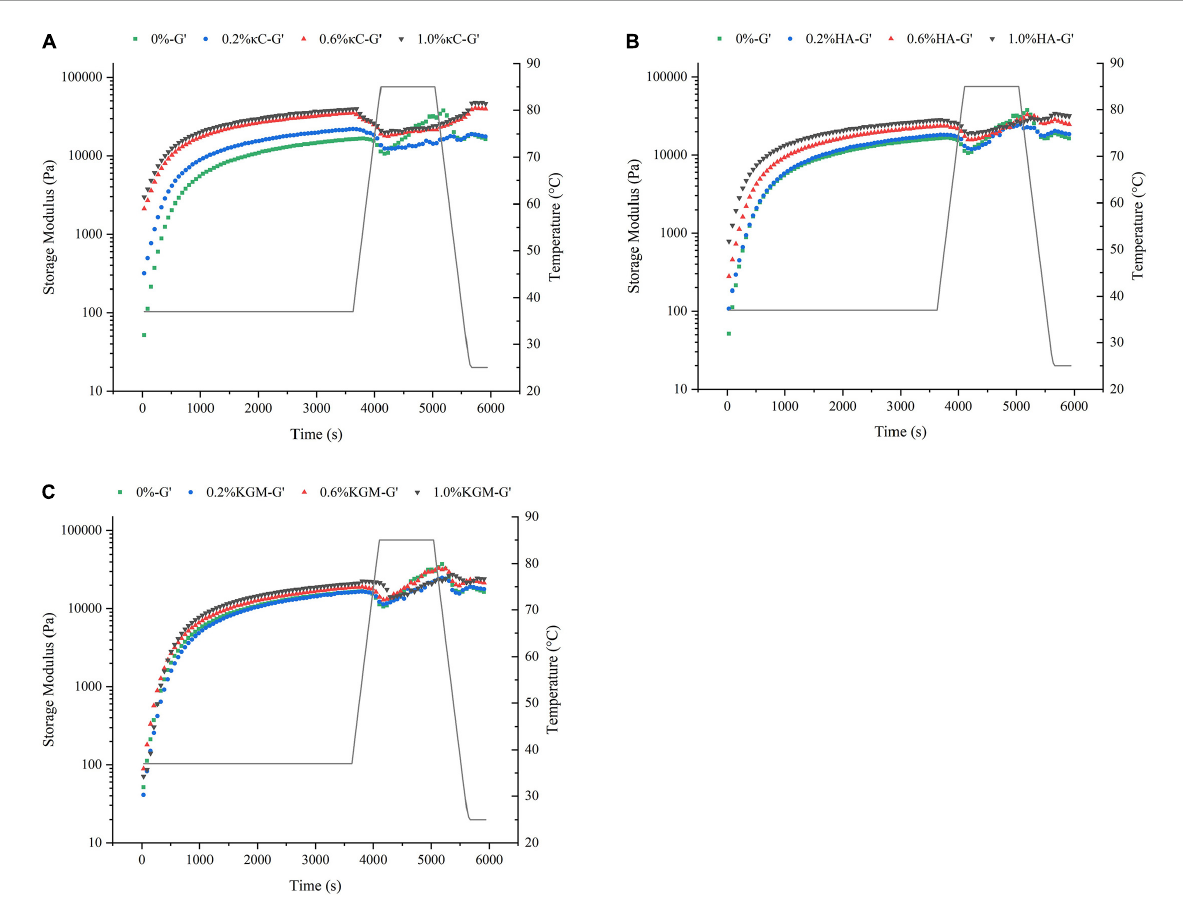
FIGURE1 Temperature cycling of the storage modulus (G’) of emulsion gels containing different polysaccharides: (A) κ C, (B) HA, and (C) KGM. κ C, κ -carrageenan; HA, high-acyl gellan; KGM, konjac glucomannanon.